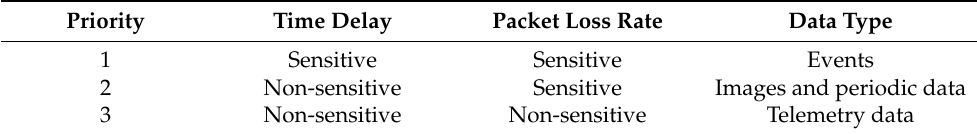
Table 1. Priority